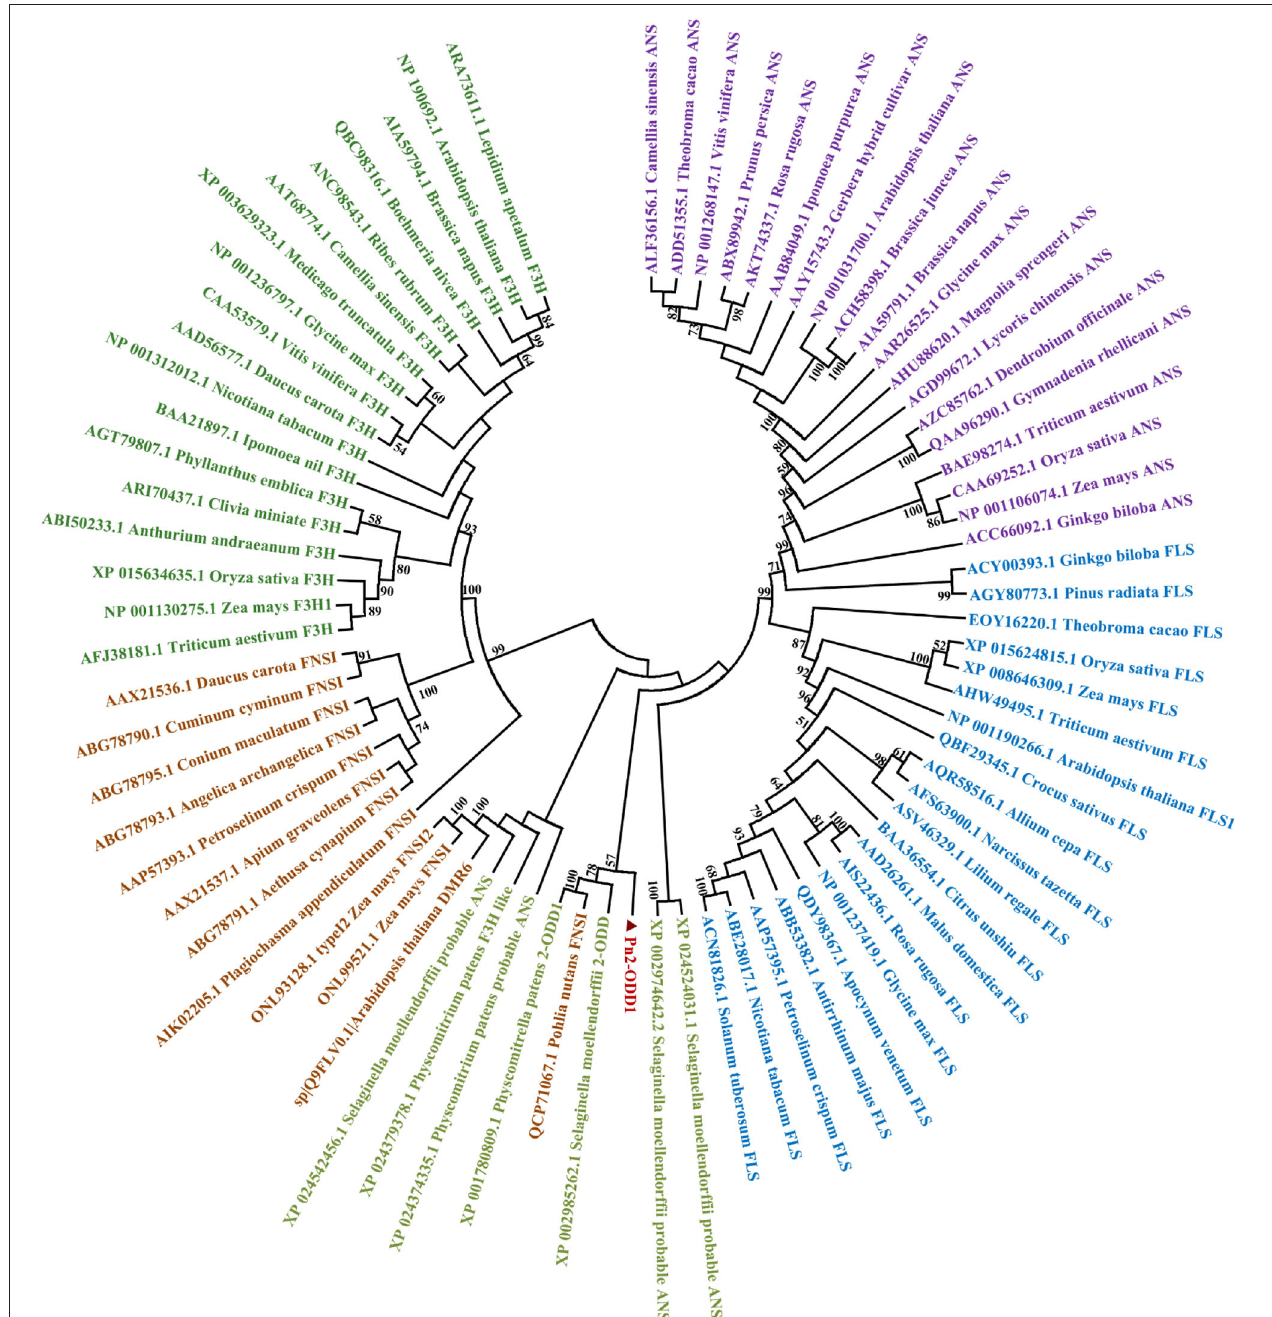
FIGURE 2 | Phylogenetic relationship of Pn2-ODD1 and other known representative 2-ODDs (mosses Physcomitrella patens and Pohlia nutans , ferns Selaginella moellendorffii , gymnosperms, monocotyledons, and dicotyledons).